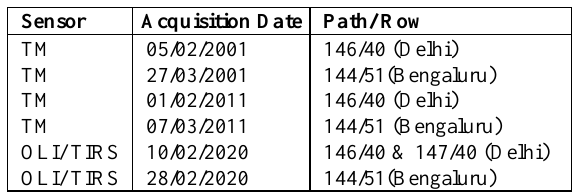
Table 1. Details of satellite images